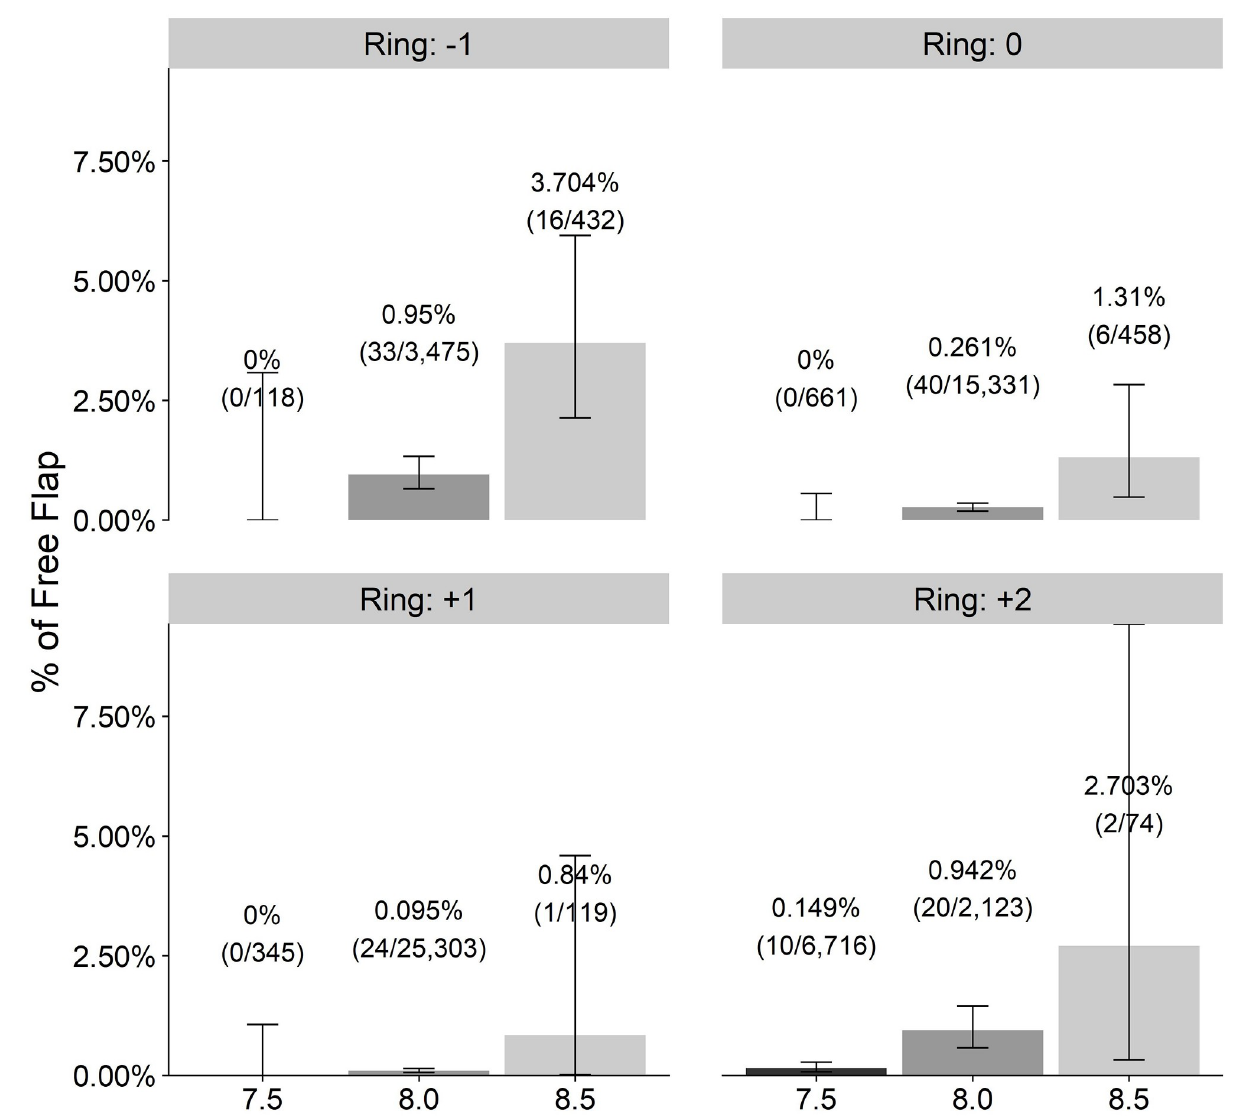
Fig 3. Free flap incidence per rings and